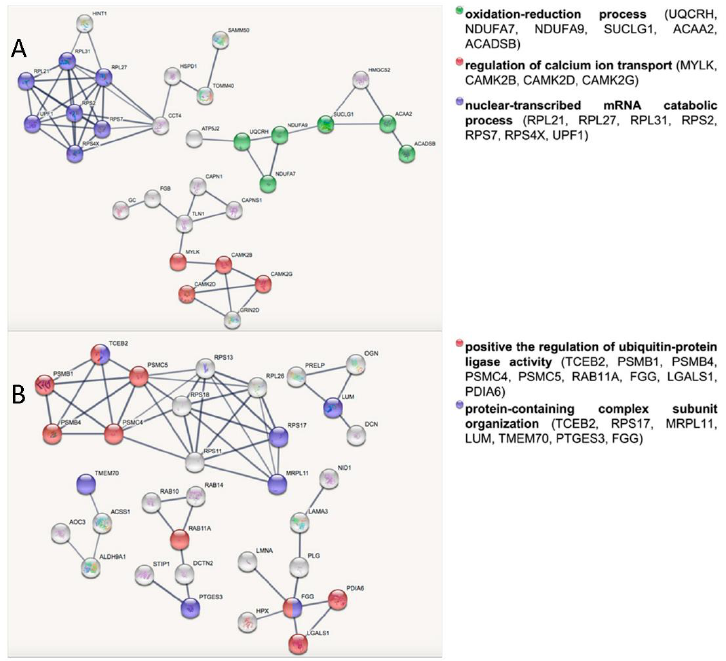
Figure 1. STRING network analysis of overexpressed ( A ) and underexpressed ( B ) proteins in skel- etal muscle from the VPG vs. CG. The node colors correspond to the enriched categories with a FDR ≤ 0.05. Table 4. Biological processes according to the results of the DAVID functional enrichment analysis of over- and underexpressed proteins in the VPG vs. CG.